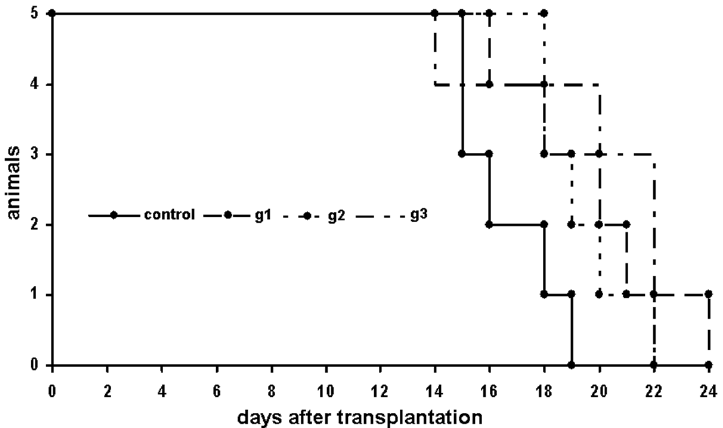
Figure 10. Lifespan observed among the P388-inoculated mice after the treatment (o.d., 10 days i.p.) with compound 29 at doses of 295 mg/kg (g1), 882 mg/kg (g2), and 1176 mg/kg (g3).